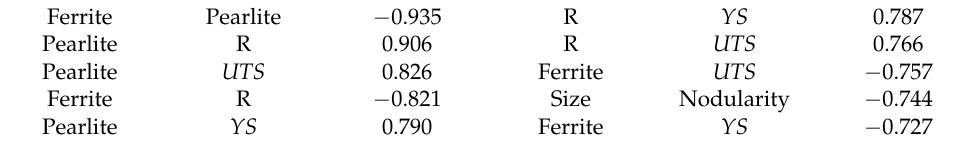
Table 3. Top ten highest correlations (in accordance with Spearman’s rank correlation, r s xy ). Ferrite Pearlite − 0.935 R YS 0.787 Pearlite R 0.906 R UTS 0.766 Pearlite UTS 0.826 Ferrite UTS − 0.757 Ferrite